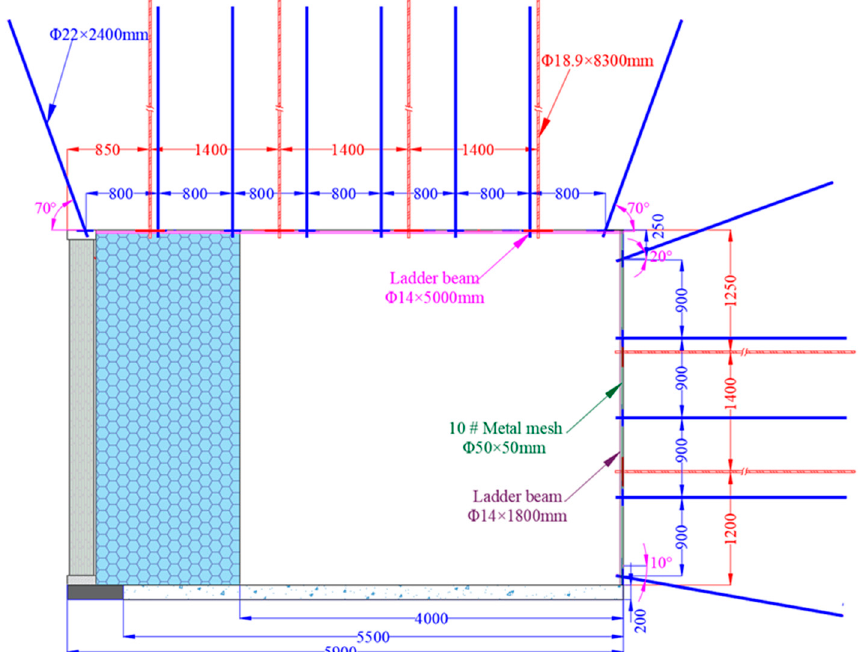
Figure 4. Cross-sectional view of the roadway support.